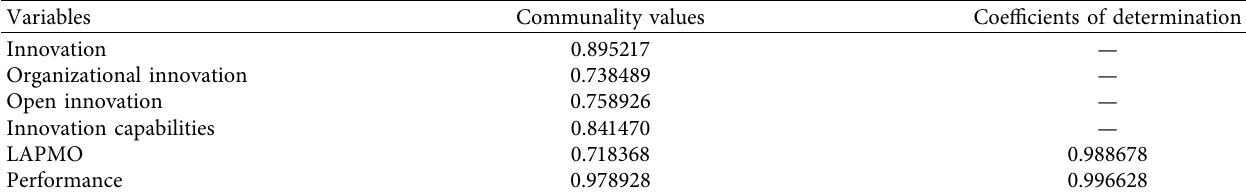
Table 8: Commonality values and coefcients of determination of dependent variables of the model (made by researchers). Variables